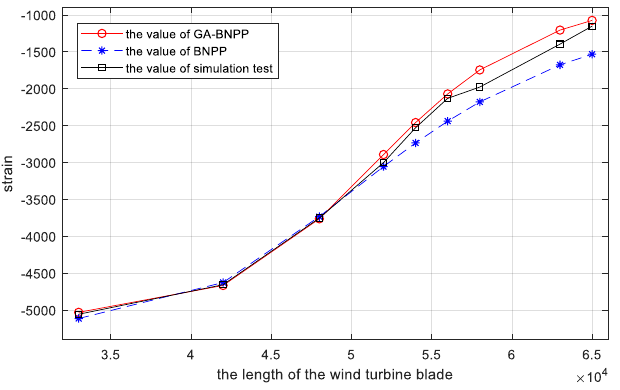
Figure 8. The comparison of GA-BPNN, BPNN, and the simulation test.